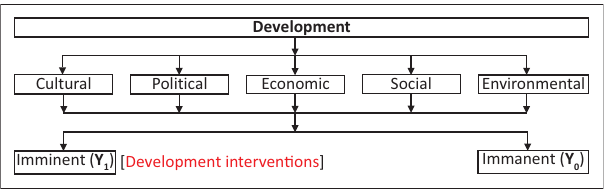
FIGURE 3: Illustrating the relationship between development and its components as well as its